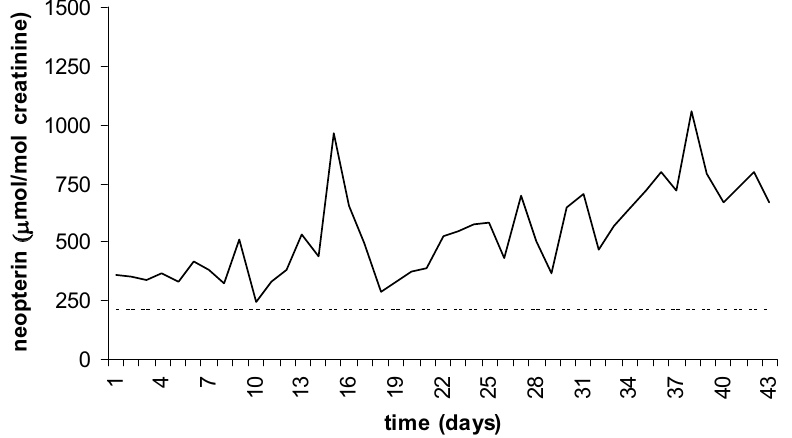
Figure 2. A 52-year-old woman with recurrent EOC and breast carcinoma presented with recurrent EOC that progressed on therapy with docetaxel and cisplatin, gemcitabine and cisplatin, and topotecan. She was treated with the combination of cetuximab (400 mg/m 2 loading dose, then 250 mg/m 2 weekly), paclitaxel (90 mg/m 2 weekly), oxaliplatin (50 mg/m 2 weekly), and continuous 5-fluorouracil (160 mg/m 2 /day). The therapy was tolera- ted well during the first weeks, but during the second week of therapy the patient reported nausea and vomiting that coincided with a marked peak of urinary neopterin concentrations. The administration of continuous 5-fluo- rouracil was interrupted on day 11 and administration of paclitaxel and oxaliplatin was suspended after 3 week- ly doses (on days 0, 7 and 14). The general condition of the patient declined further during subsequent adminis- tration of cetuximab in monotherapy on days 21, 28 and 35. The course of urinary neopterin concentrations was characterized by marked fluctuation and a gradual increase during the observation period. The rise of urinary neopterin reflected the deterioration of the condition of the patient who was complaining of weakness, nausea and, in the last week of observation, pain associated with the tumor growth. The patient died 13 days after the last measurement. Serum CA125 was markedly increased (20 000 U/ml and above) throughout the course of ther- apy. The upper limit of normal urinary neopterin concentrations is indicated by dashed